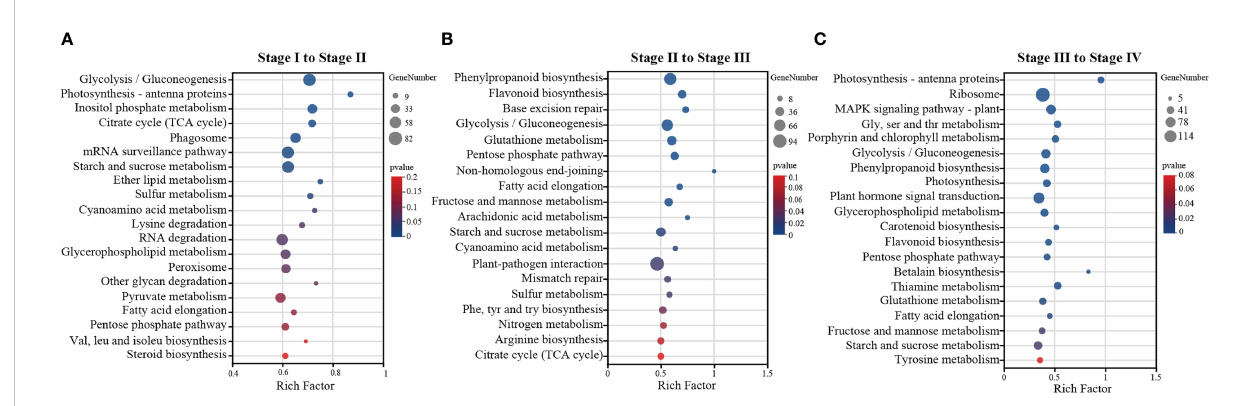
FIGURE 4 KEGG enrichment analysis of DEGs identi fi ed by pairwise comparison were performed by R package (version 1.0) clusterPro fi ler. (A) stage I to stage II, (B) stage II to stage III, (C) stage III to stage IV. The y-axis is the name of KEGG pathway, x-axis represents the ratio of the number of genes annotated in this pathway to background differentially expressed genes in this pathway. Size of circles indicates the number of enriched genes in each pathway, and the color represents the level of signi fi